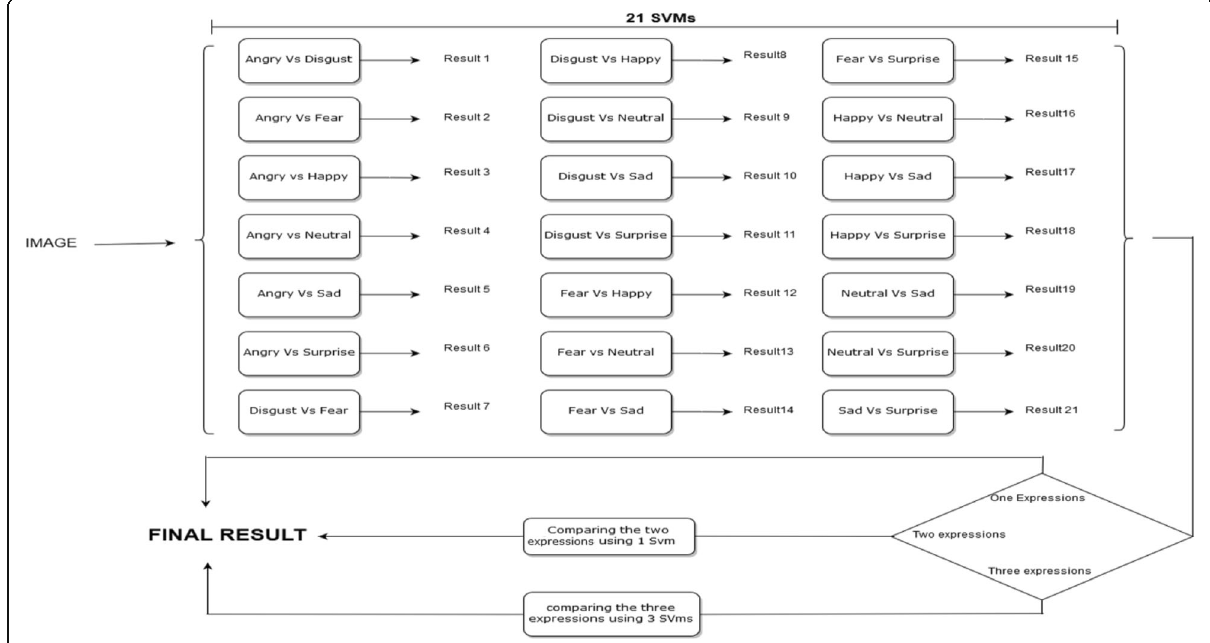
Fig. 2 Two-stage model: first stage (21 SVM) and Second and third stages combining the results of Stage